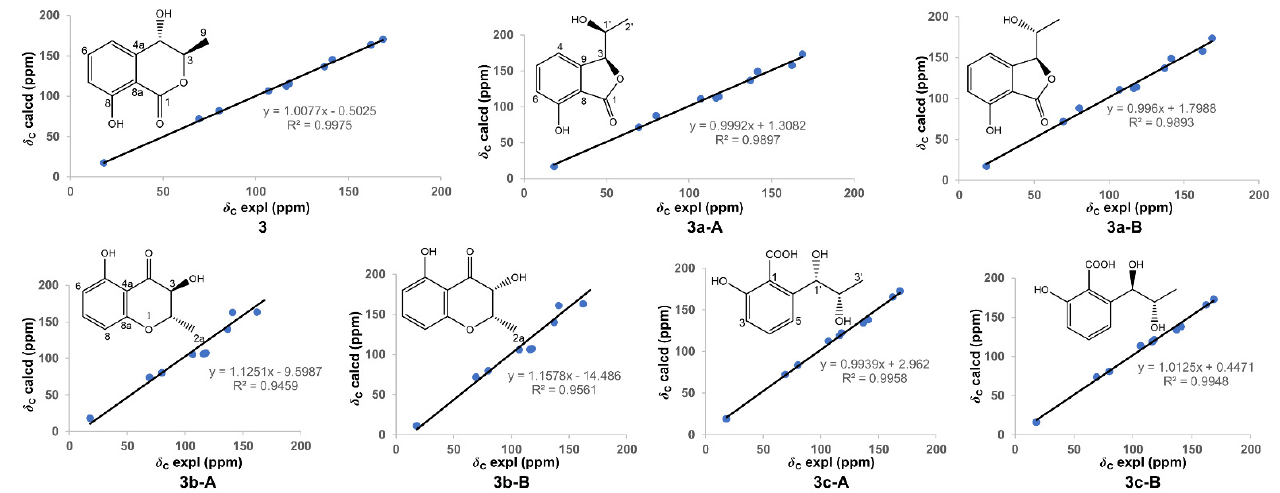
Figure 5. Configurations and linear correlations between the calculated and experimental 13 C NMR shifts of 3 , 3a - A , 3a - B , 3b - A , 3b - B , 3c - A , and 3c - B .